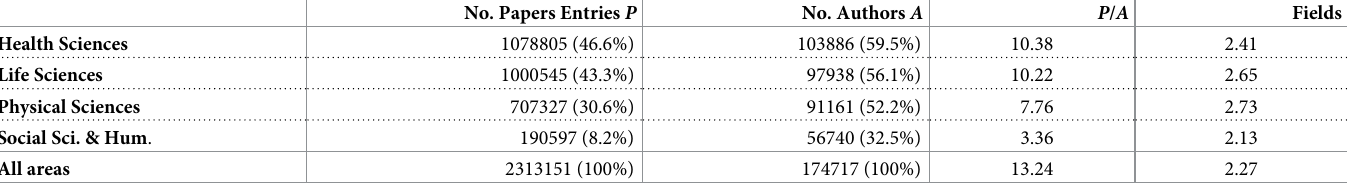
Table 1. Data statistics. For each macro area X shown in the rows, columns report the number of publications entries on venues associated with X , number of researchers who authored one or more publications on such venues, the average number of papers published by these authors on those venues and the average number of sub-areas associated with those publication